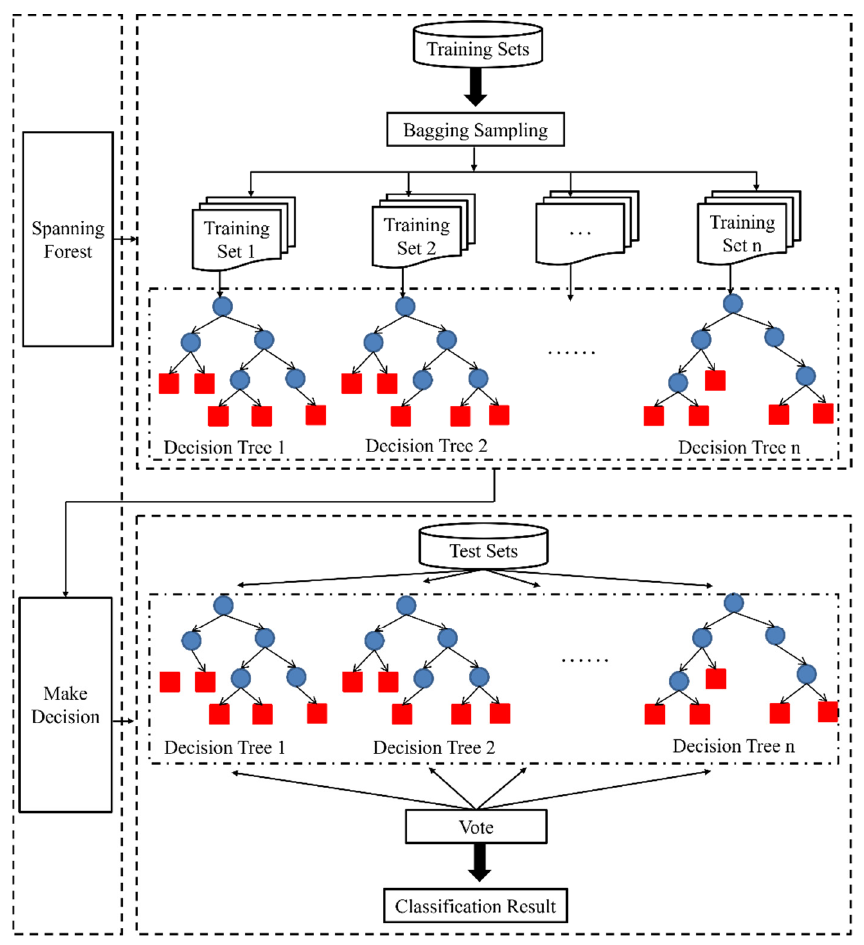
Figure 9. Random forest